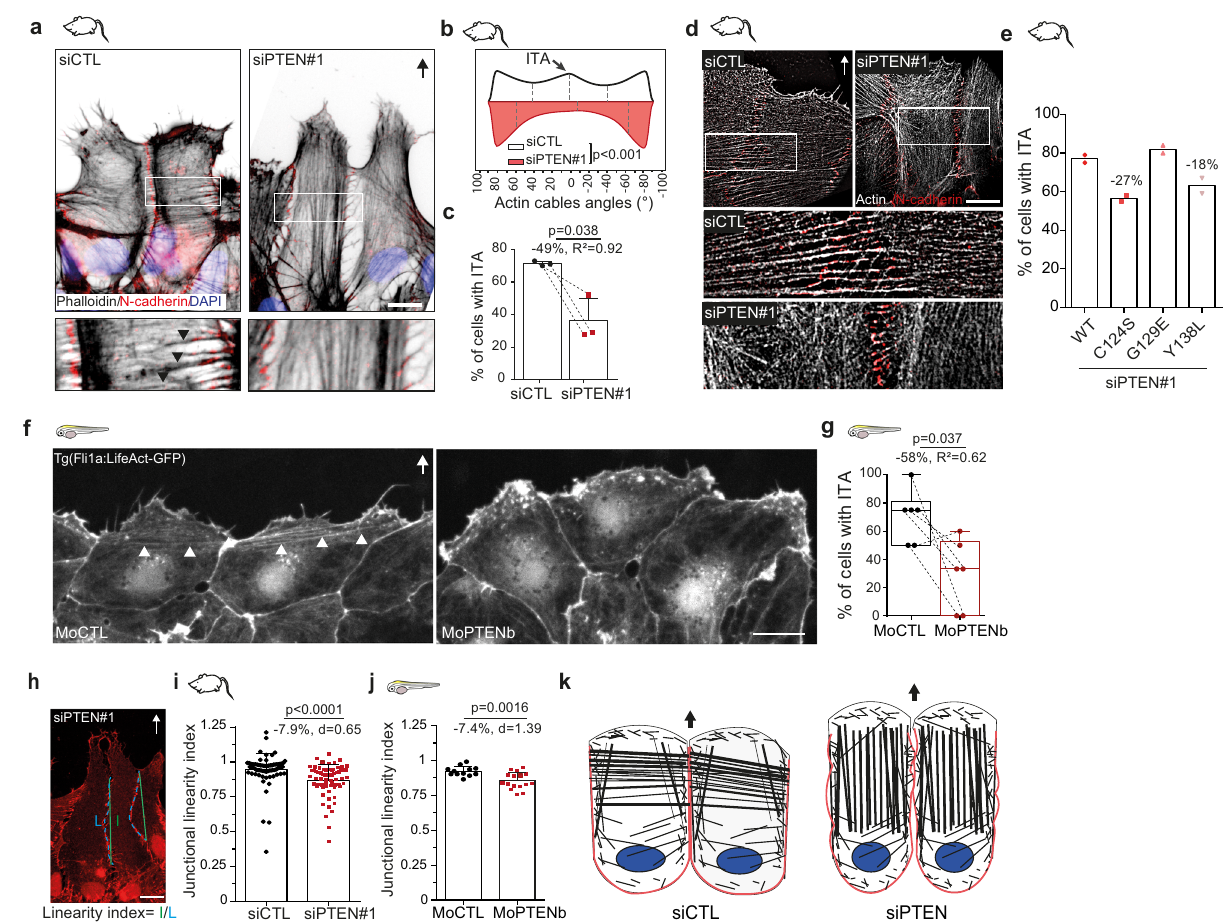
Fig. 2 PTEN controls fi rst-row cell-cell cohesion. a , d Normal ( a ) and super resolution ( d ) immuno fl uorescence images of actin fi laments (phalloidin), cell- cell junctions (N-cadherin) in siCTL and siPTEN#1 migrating astrocytes. Black arrow: direction of migration. Boxed regions are zoomed in the panels below to highlight the presence of interjunctional transverse actin arcs (ITA) mostly in siCTL cells (black arrowheads). The micrographs in ( a ) are representative of the data shown in ( b , c ). The images in ( d ) are representative of six independent samples. b Angular distribution of actin fi laments in front row siCTL and siPTEN#1 cells ( n = 300). 0° is perpendicular to the direction of migration. Graph represents Kernel density estimates of probability density function. Dashed lines show quartiles. c , e Proportion of front row siCTL and siPTEN#1 cells with ( e , n = 200) or without ( c , n = 300) wt- and mutated-PTEN rescue, that are connected with ITA. f Fluorescence images of CCV ECs expressing LifeAct-GFP in CTL and ptenb morphant fi sh. White arrowheads point at ITA. g Percentage of front row CCV EC cells connected by ITA in MoCTL ( n = 36 cells) and MoPTENb ( n = 29 cells) fi sh larvae. Box extends from the 25th to 75th percentiles and the line in the middle of the box is plotted at the median. The whiskers delineate all data points from minimum to maximum. h Immuno fl uorescence image of N-cadherin in migrating astrocytes, where the linearity index of front row lateral cell-cell junction is de fi ned. i Junctional linearity index in siCTL ( n = 70) and siPTEN#1 ( n = 65) cells, 8 h after migration. j Junctional linearity index in MoCTL ( n = 12) and MoPTENb ( n = 16) front row cells, 100 min after migration. k Schemes summarising PTEN loss phenotype in front row cells during collective cell migration. Scale bars: 10 µ m. Number of independent experiments = 2 ( e , i ), = 3 ( b , c , j ). Statistical tests: Kolmogorov-Smirnov ( b ), two-tailed paired t -test ( c , g ), two-tailed Mann – Whitney ( i ), two-tailed unpaired Student t test ( j ). p values, along with effect size coef fi cients are given on the graphs. Error bars represent SD. Source data are provided as a Source Data fi